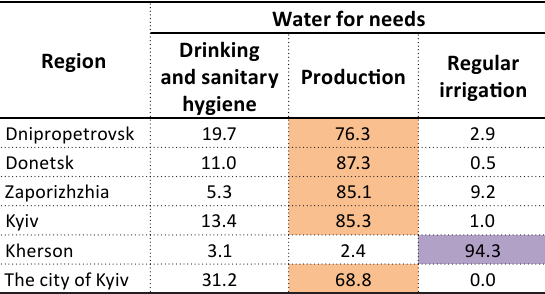
Table 2. Specific weight of water use according to directions in 2017, %